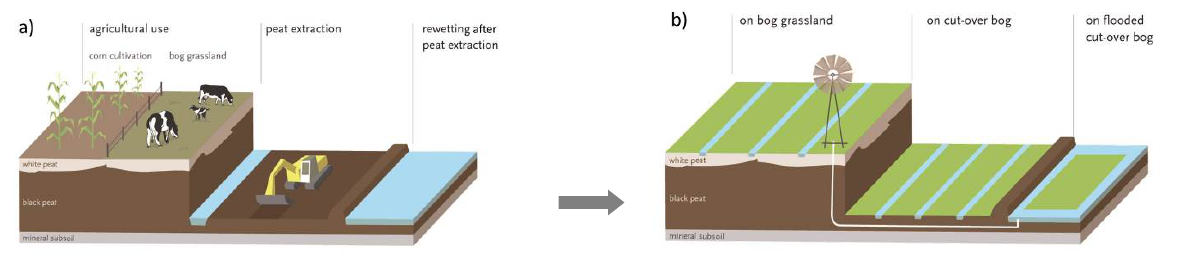
Figure 1. Mosaics of a) current land use on degraded bogs in NW Germany and b) Sphagnum cultures after rewetting (after Gaudig et al.